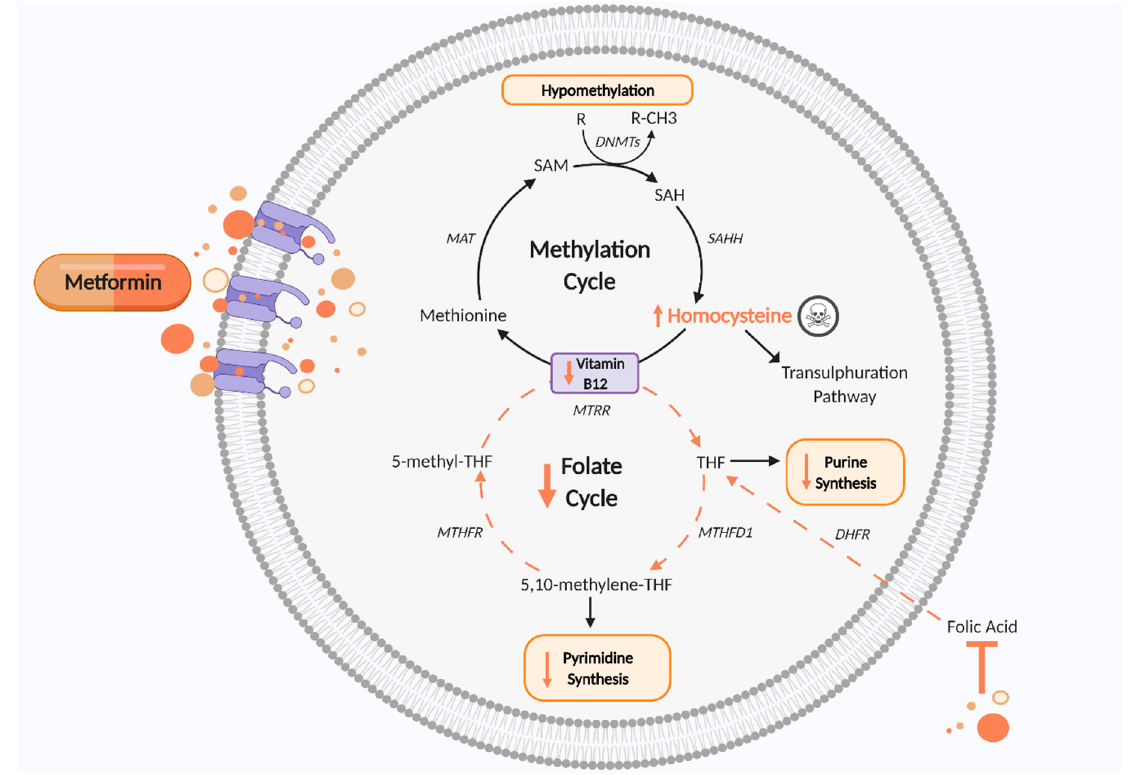
Figure 3. Disturbed one carbon metabolism induced by metformin. Metformin reduces vitamin B 12 , thus impairing the methylation cycle and leading to increased Hcy levels, which are cytotoxic, and hypomethylation of proteins and nucleic acids, which may cause epigenetic changes. The folate cycle is also disturbed by metformin’s antifolate-like activity, thereby reducing pyrimidine and purine synthesis and disrupting cell growth and proliferation. DHFR, dihydrofolate reductase; DNMTs, DNA methyltransferase; MAT, methionine adenosyltransferase; MTHFD1, methylenetetrahydrofolate dehydrogenase 1; MTHFR, methylenetetrahydrofolate reductase; MTRR, methyltransferase reductase; SAH, S adenosyl L homocysteine; SAHH, adenosylhomocysteinase; SAM, S-adenosyl methionine; THF, tetrahydrofolate. Black arrows indicate cellular pathway. Orange arrows indicate putative effects of metformin. Figure created using Biorender.com.